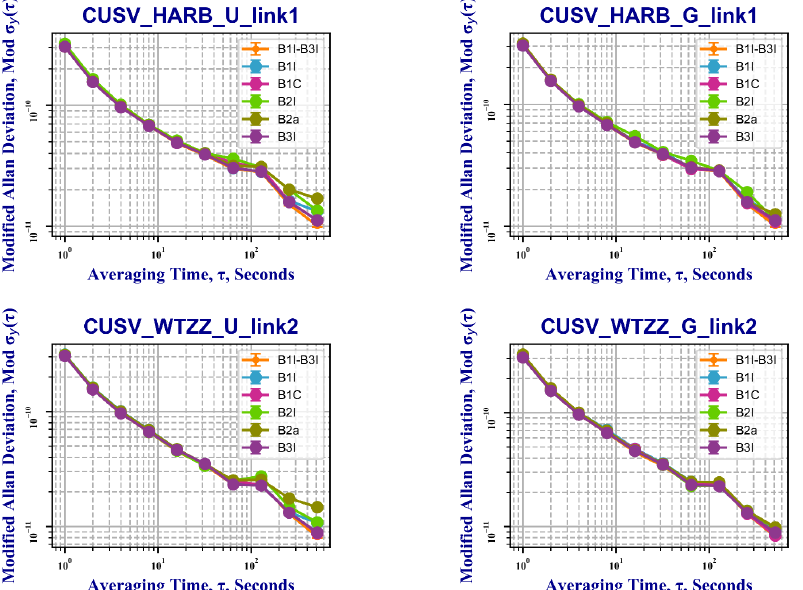
Figure 14. The frequency stability results of the two links of the two strategies (U, Strategy 1; G, Strategy 2).